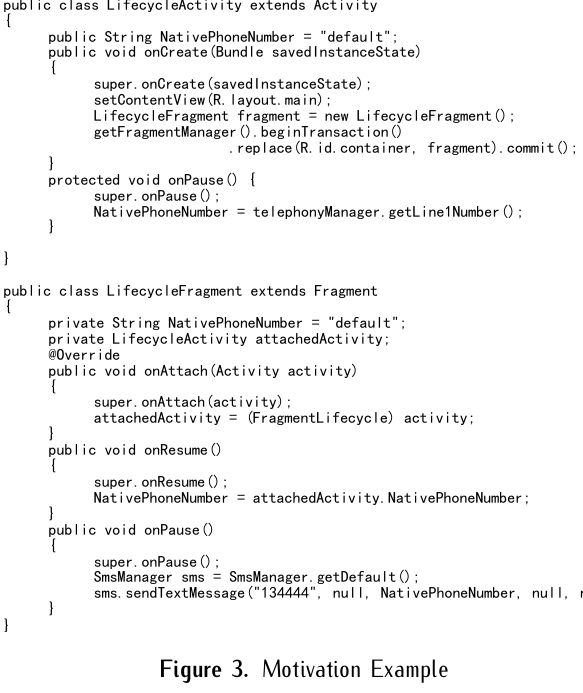
Figure 3. Motivation